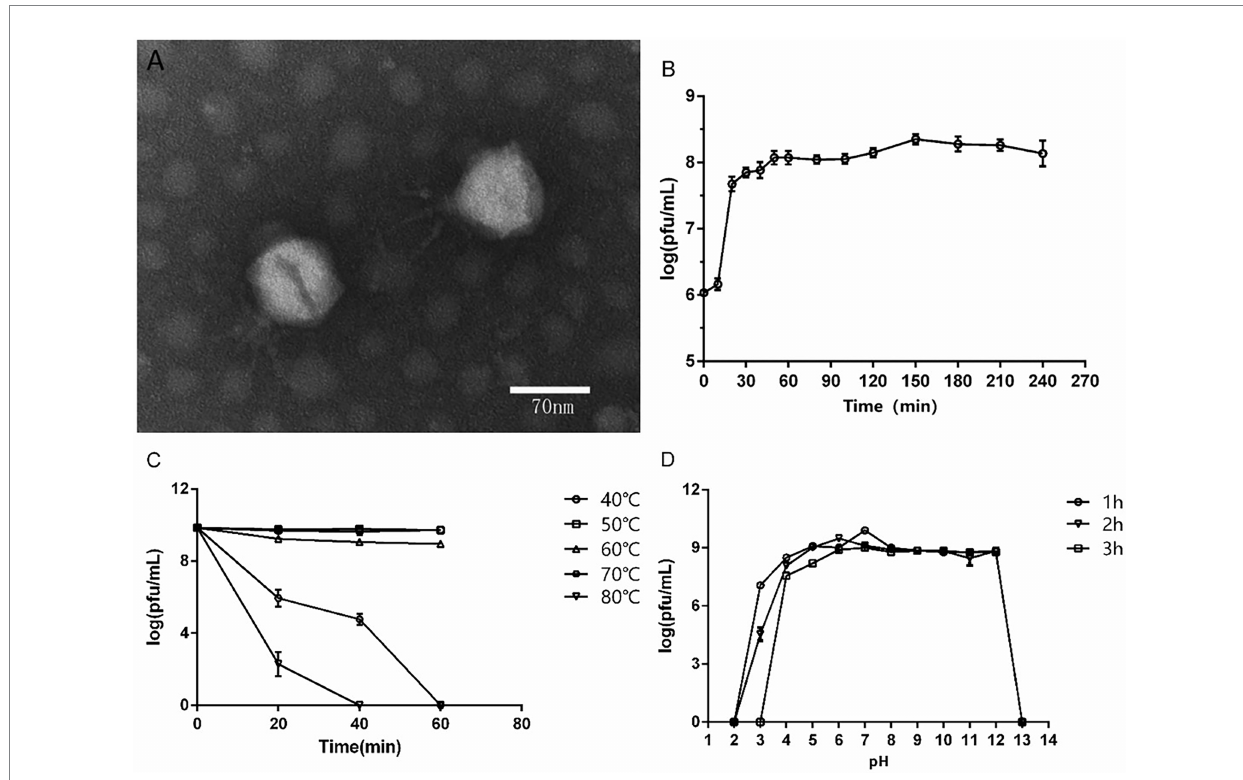
FIGURE 1 Biological characteristics of phage ASP23. (A) TEM image of phage ASP23. Phage ASP23 had an icosahedral head of 70 nm in diameter and a short tail with 40 nm in length. (B) One-step growth curve of ASP23. The latent period and burst size were 10 min and 140 pfu/infected cell. (C) Temperature sensitivity of ASP23. The phage titers were no significant differences at 40 ° C ~ 60 ° C. (D) pH stability of ASP23. Phage ASP23 was stable over a broad range of pH (5–12). Data are expressed as mean ± SD ( n =